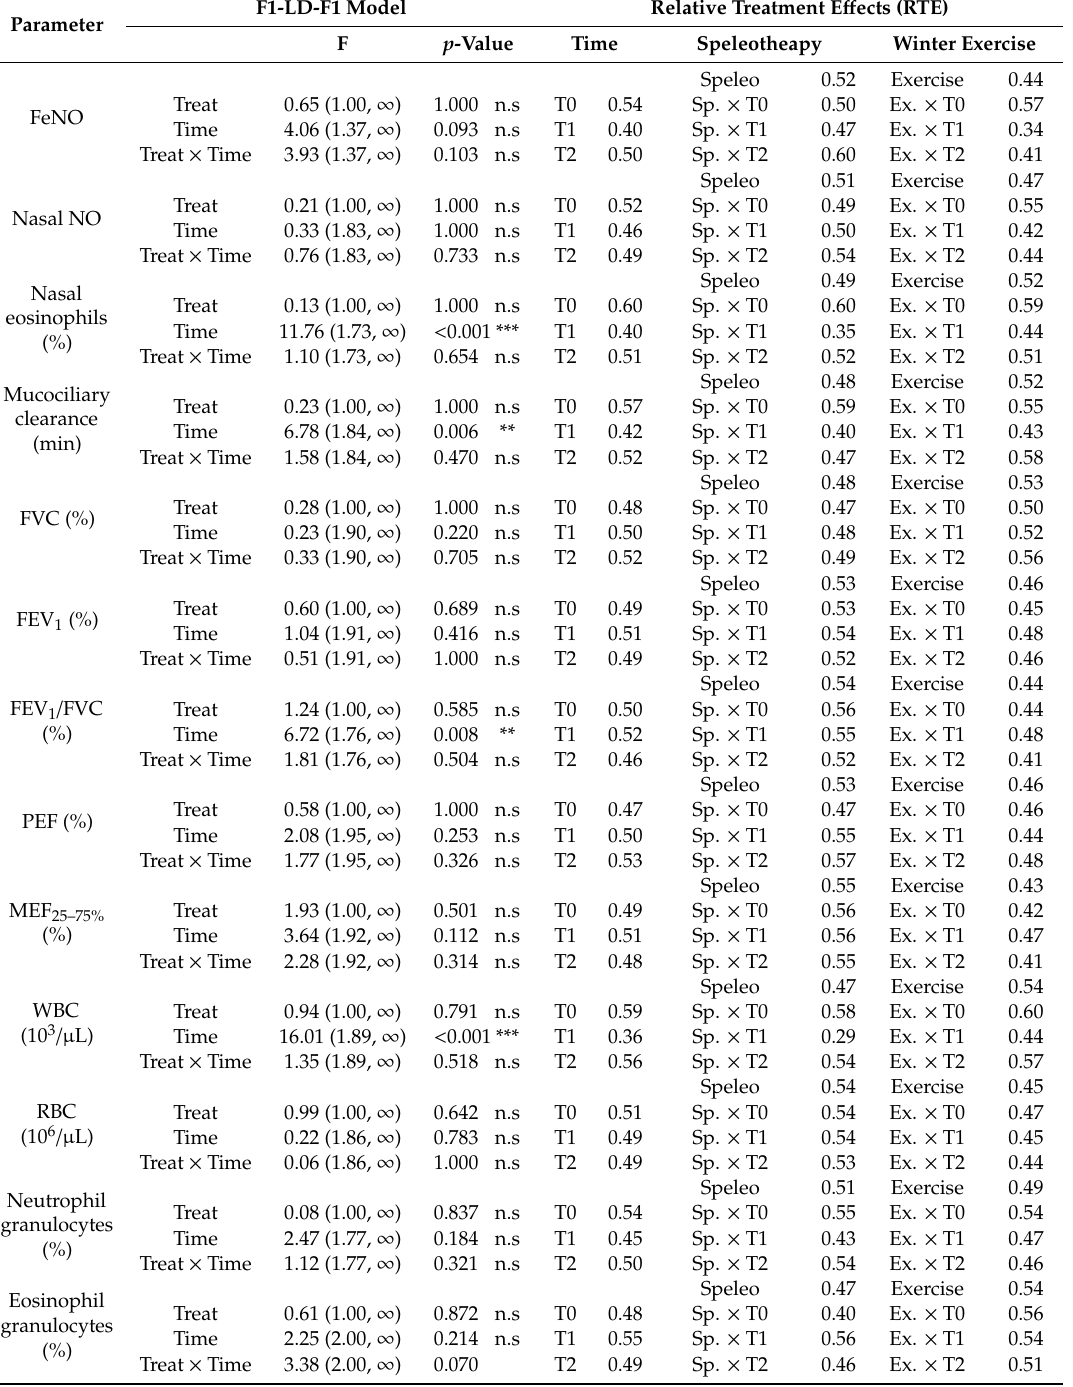
Table 3. Results from the F1-LD-F1 model reporting time, treatment, and interaction e ff